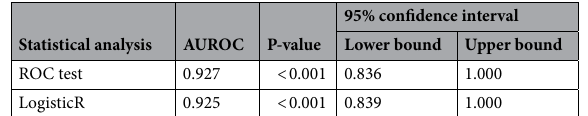
Table 7. Diagnostic performance of the Pm–Ps–Fn–Am four-bacteria CRC biomarker panel.